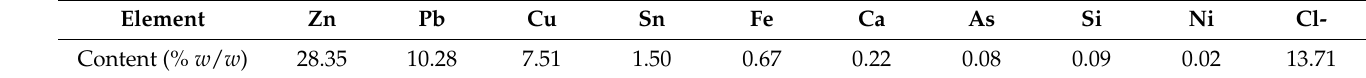
Table 1. Chemical composition of the copper anode furnace dust analyzed by